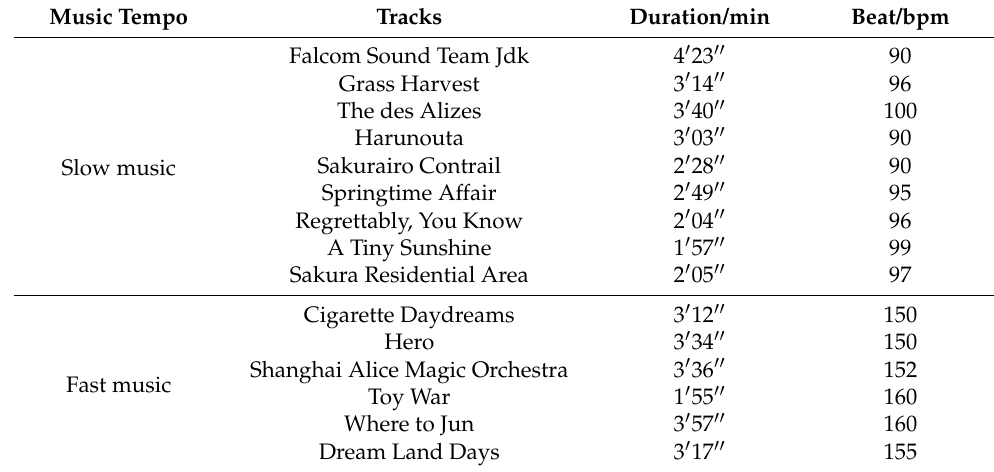
Table 2. Details of music